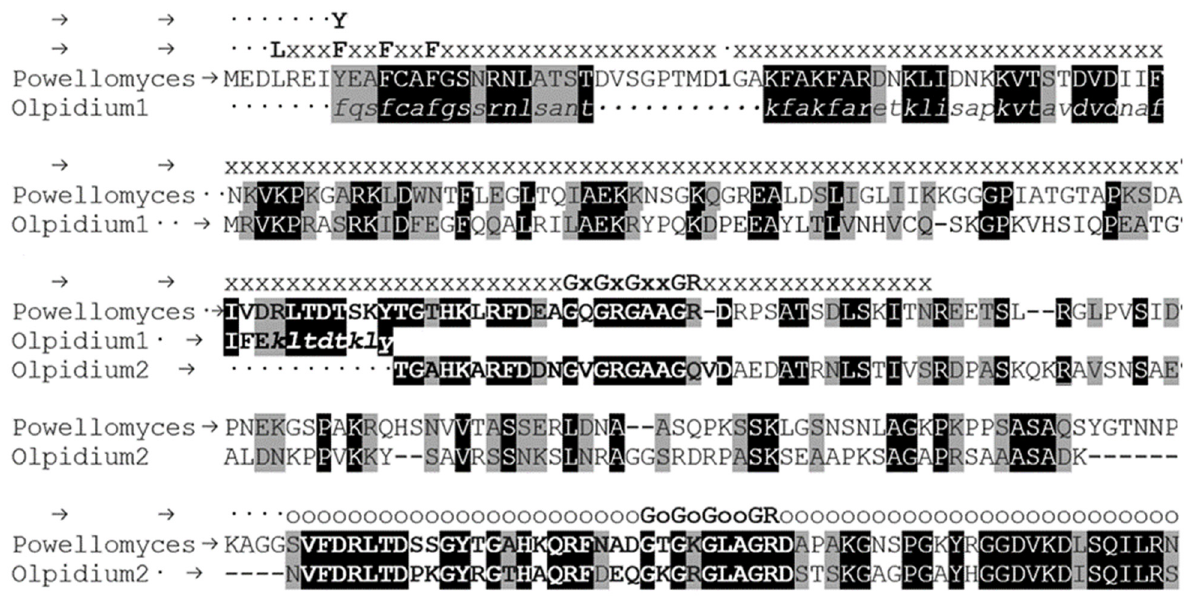
Figure 3. Alignment of Olpidium bornovanus and Powellomyces hirtus proteins by Clustal Omega [19]. Olpidium 1— O. bornovanus KAG5460860, hypothetical protein, partial. Olpidium 2— O. bornovanus KAG5458366, hypothetical protein, partial. Powellomyces— P. hirtus TPX57673, hypothetical protein.